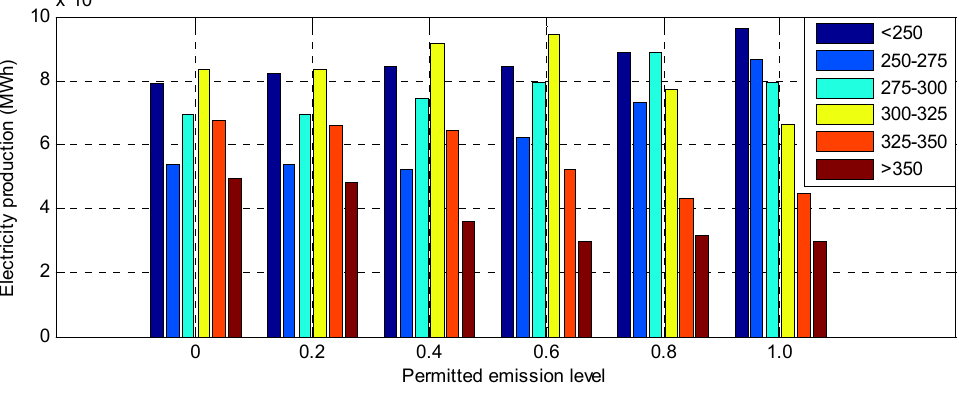
Figure 5. Tax revenue under different permitted emission